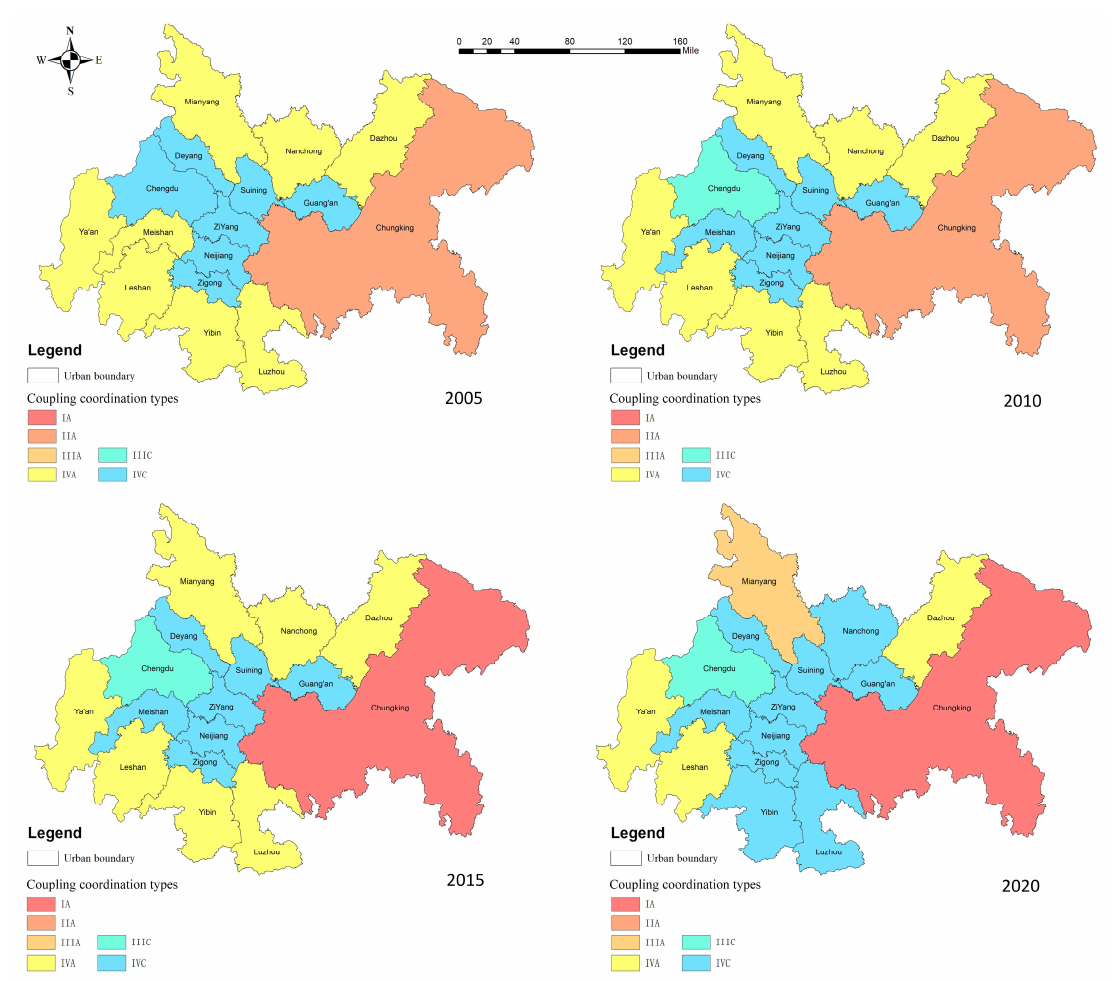
Figure 12. Distribution of the types of coupling and coordination between economic–social